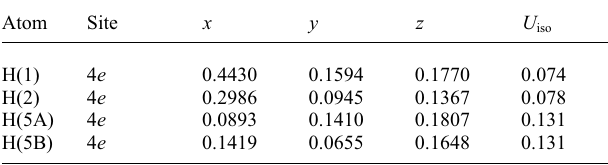
Table 2. Atomic coordinates and displacement parameters (in Å 2 )